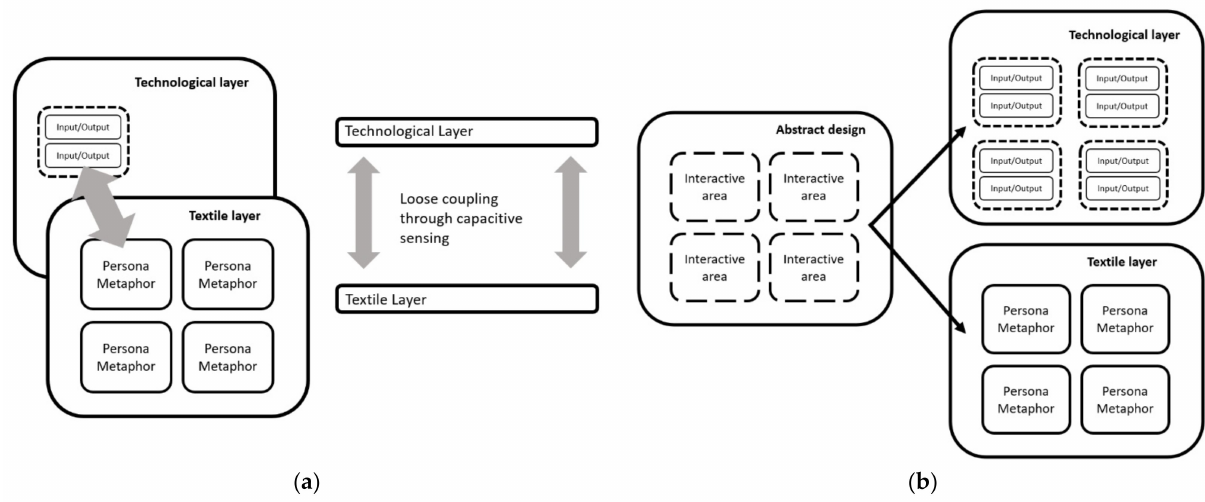
Figure 2. Overview of textile design: ( a ) Loose coupled layers—layers are aligned correctly through press studs and Velcro fastenings; ( b ) Implementing layers from design—a single design is sufficient to produce the layer with Input/Outputs. Input = capacitive sensors; Output = LEDs, vibrator motor, music